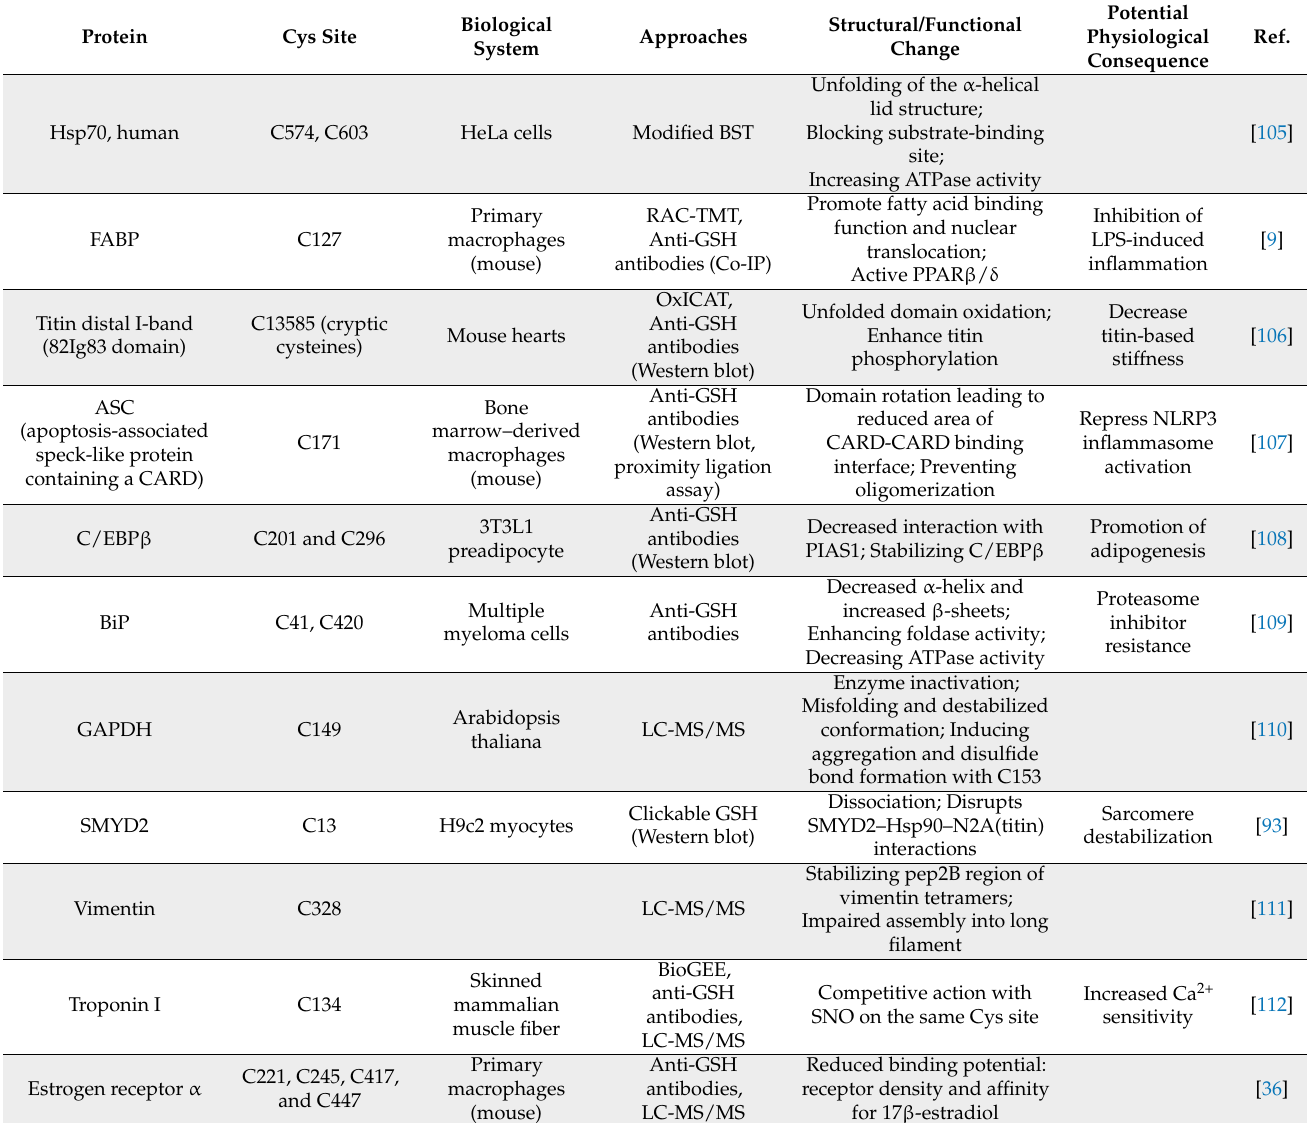
Table 2. List of novel SSG-regulated proteins discovered by proteomics followed by functional